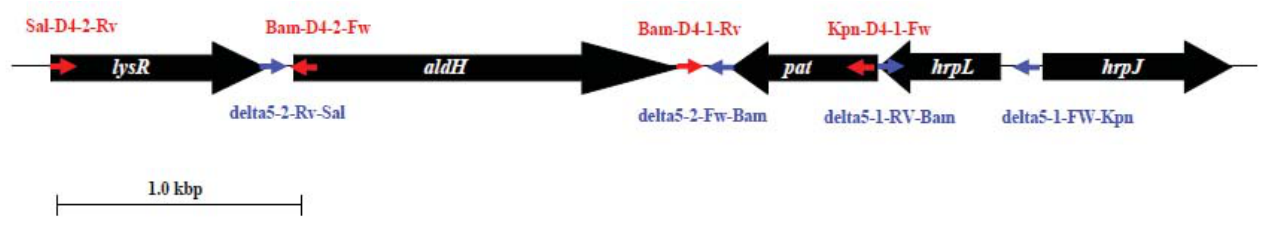
Figure S1. Assembly of open reading frames of the DNA region in the flanking region of hrp of P. cichorii strain SPC9018 genomic DNA including aldH and pat and position of primers used for constructions of plasmids for the aldH- deleted mutant (red-colored) and the pat -deleted mutant